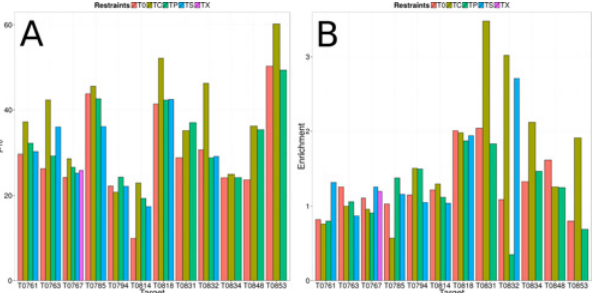
Fig 5. Sampling accuracy and model discrimination for 'assisted' targets. (A,B) The average GDT_TS values of the most accurate models ( μ 10 ) and the enrichments are compared for protein structure prediction without restraints (T0), with predicted residue-residue contacts (TP), only correct residue-residue contacts (TC), NMR-NOE restraints (TS), and MS-XL restraints (TX).